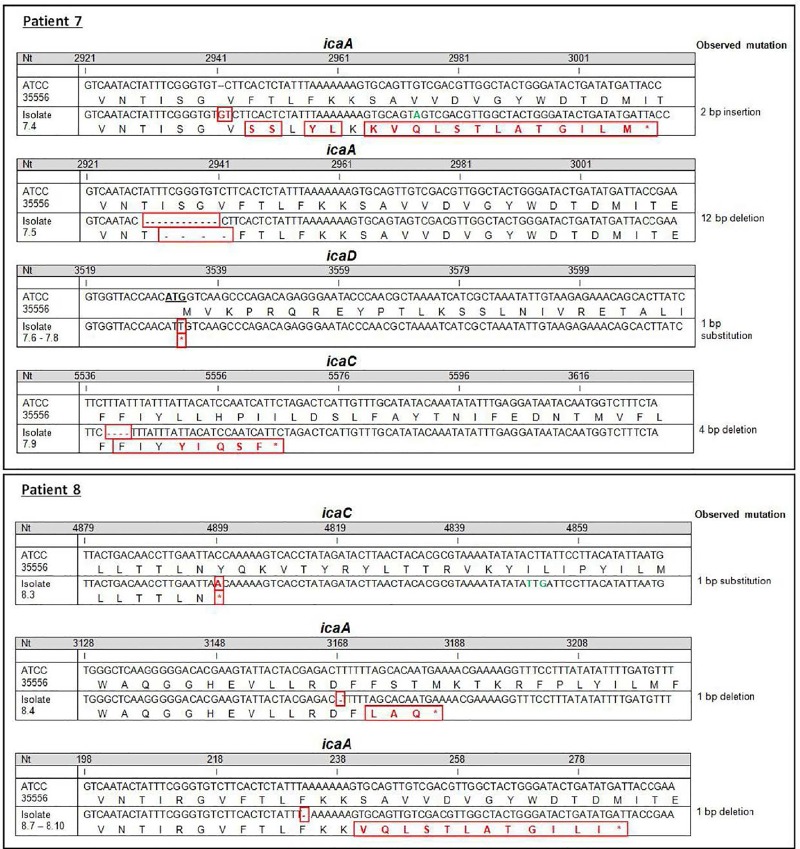
Mutations of non-mucoid S. aureus isolates with 5 bp deletions.During persistence, non-mucoid S. aureus isolates with 5 bp deletions and compensatory mutations in icaA, D and C were identified. The ica-sequences of 12 non-mucoid isolates with 5 bp deletions of patients 7 (A) and 8 (B) are illustrated. The numbering of bases and amino acids (aa) follows the sequences retrieved from S. aureus strain ATCC35556 (SA113). Changes of bases, amino acids and deletions are indicated in red color. Synonymous changes are indicated in green. S. aureus strains are identified by the number of the patient's visit and the date of isolation. For patient 7, the same mutation was identified for isolates from visits 14, 15 and 16 and for patient 8 for isolates from visits 27, 43, 49 and 51, respectively. Only the mutation for the first identified isolate is shown.